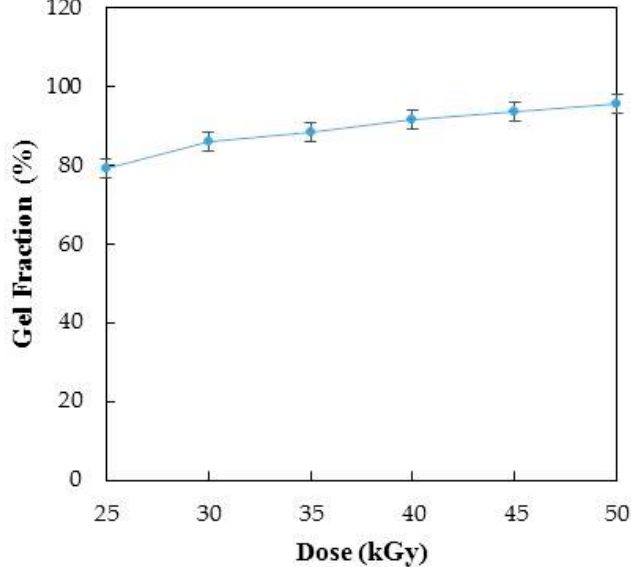
Figure 1. Effect of radiation dose on gel fraction of PA15 hydrogel.